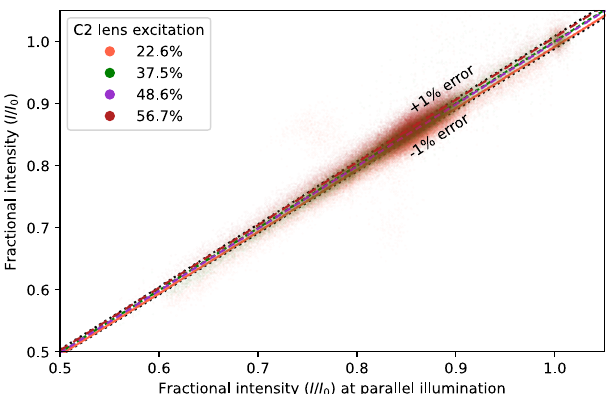
Fig. 8 An exploration of the errors introduced in the measurement of TEM image fractional intensity with non-parallel illumination. For an ice- covered carbon Quantifoil TEM grid, images were recorded for different values of C2 excitation, which cause non-parallel illumination if not set to 48.6% at the chosen spot size. Pixel values are compared with their equivalent in the image recorded with parallel illumination. Even a large change to the C2 excitation (22.6%) is not enough to get a >1% error in measured fractional